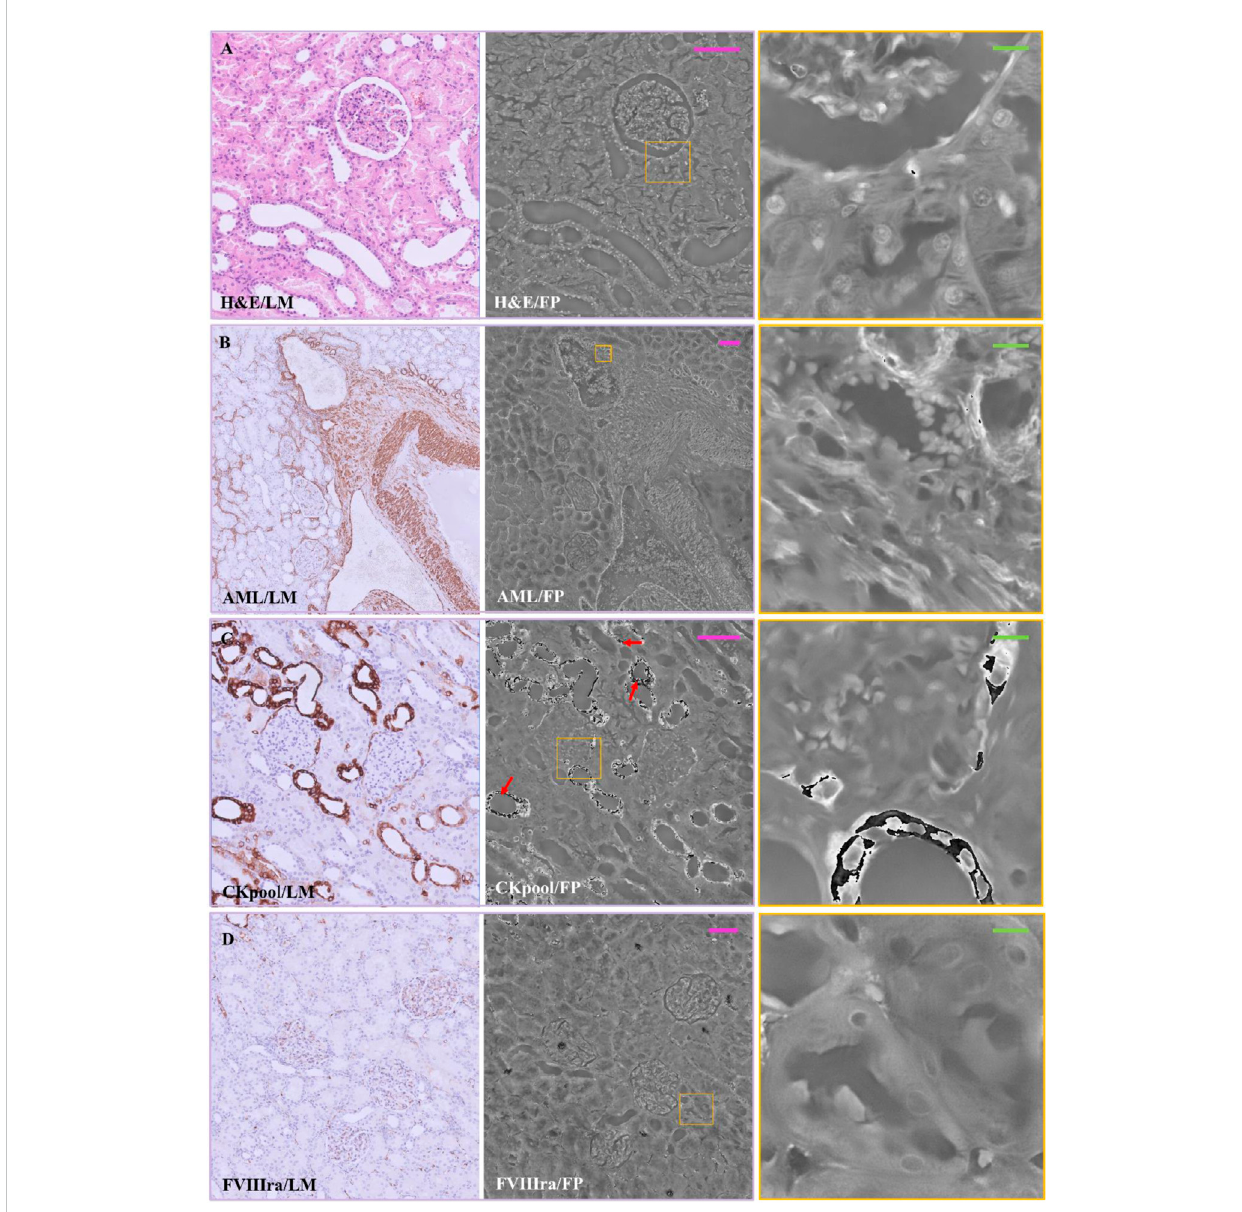
FIGURE 2 Stainedrenal tissue slides: Renal tissue portions with 3 µmthickness are stained with various dyes and captured by(left) LM and (center/right) FP. (A) H&E; (B) AML; (C) CKpool; (D) FVIIIra. Scale bars: 105 µm. Red arrows in C indicate the phase jumps. On the right, the zoomed patches of the corresponding yellow boxes have the green scale bar of ~13